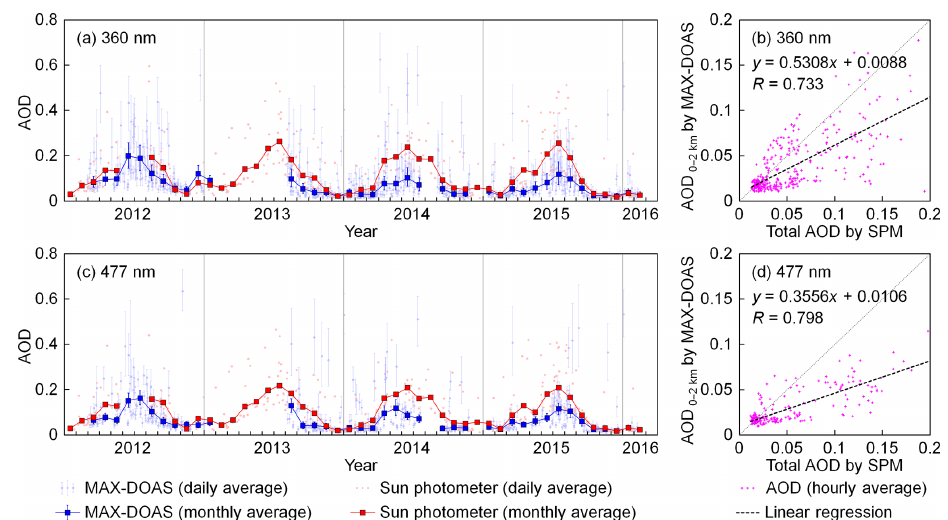
Figure 14. Comparison of AODs at (a, b) 360nm and (c, d) 477nm measured by the MAX-DOAS and sun photometer. The charts on the left side (a, c) show the daily and monthly averaged time series, whereas the scatter plots on the right side (b, d) show the hourly averaged results. The AOD measured by MAX-DOAS refers to the vertical range between 0 and 2km (i.e., τ 2k ( ˆ x ) = 0 . 5 σ 1 ( ˆ x ) + 0 . 5 σ 2 ( ˆ x ) + σ 3 ( ˆ x ) ) above the instrument (i.e., 2650–4650ma.s.l.). The measurements were available during daytime with SZA < 85 ◦ and cloud-free conditions. The AOD measured by the sun photometer refers to the total AOD, and only the measurements during 10:00–14:00UTC were used due to their accuracy. The daily and monthly averaged results are calculated from all the available hourly averaged AODs; therefore they are not real monthly and daily averages. The error bars of the MAX-DOAS data refer to the averages of the uncertainties calculated by Eqs. (16) and (17). A few data points are outside the scatter plots.